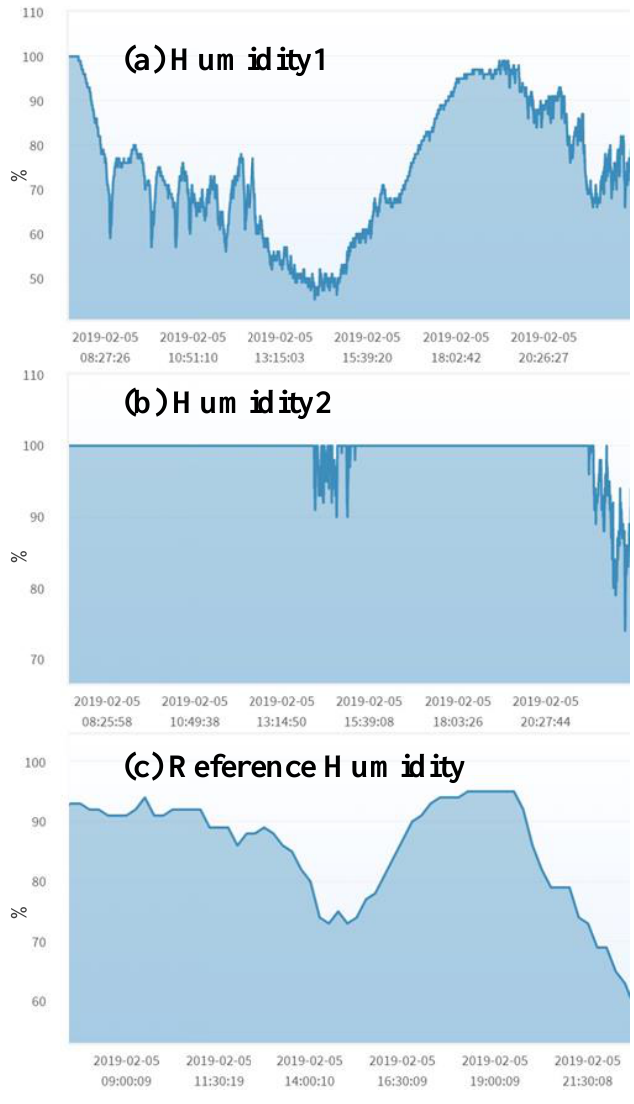
Figure 8. Humidity (Wufeng).